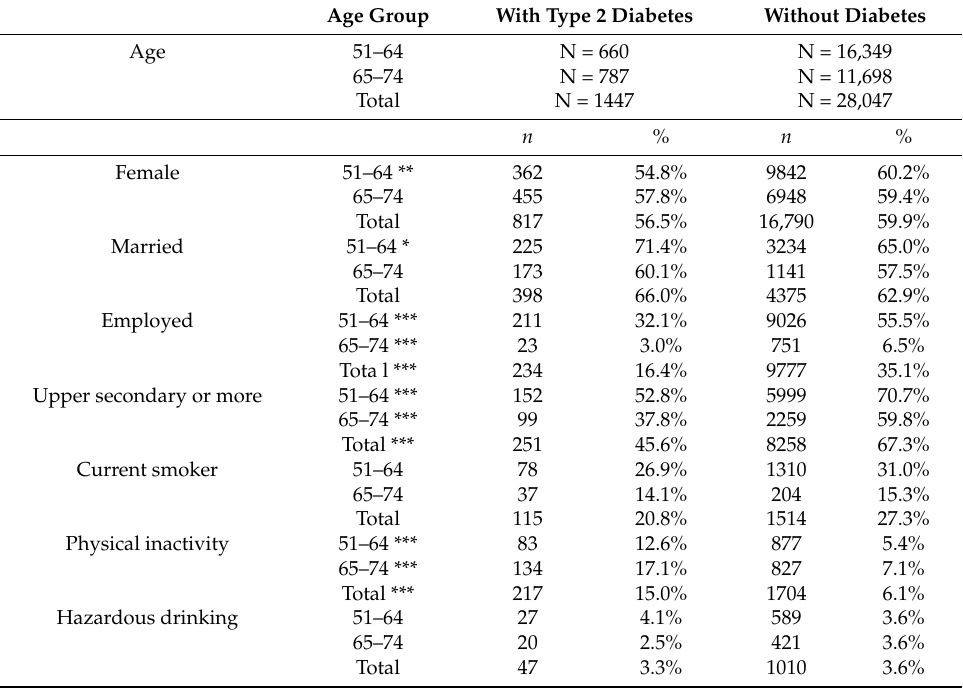
Table 1. Comparison of socio-demographic, behavioral risks and health characteristics between participants with type 2 diabetes and without diabetes for the two age groups, between 51 and 64 and between 65 and 74 years